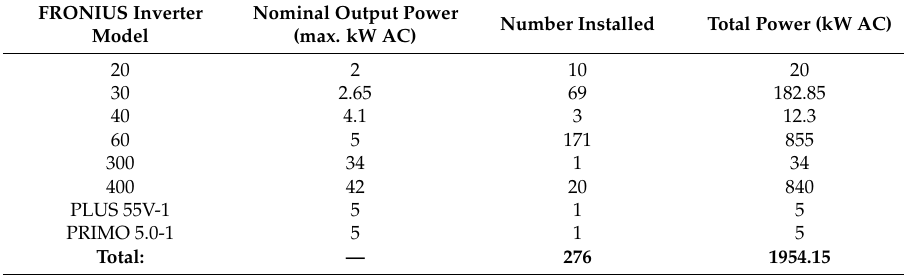
Table 2. Description of the 276 inverters installed in the Y é char solar photovoltaic plant. The model, nominal maximum output AC power, number installed and total power per each model of inverter and total per the plant are